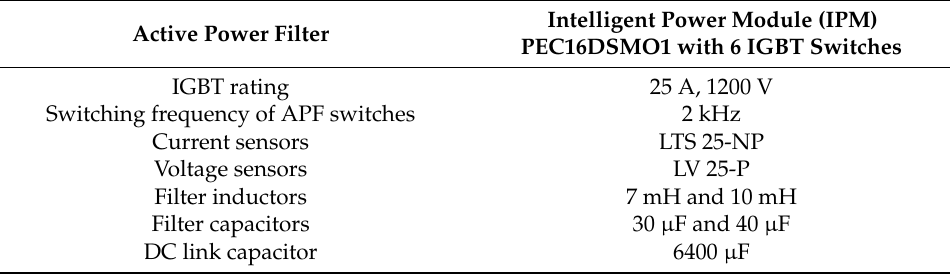
Table 2. Experimental circuit parameters.